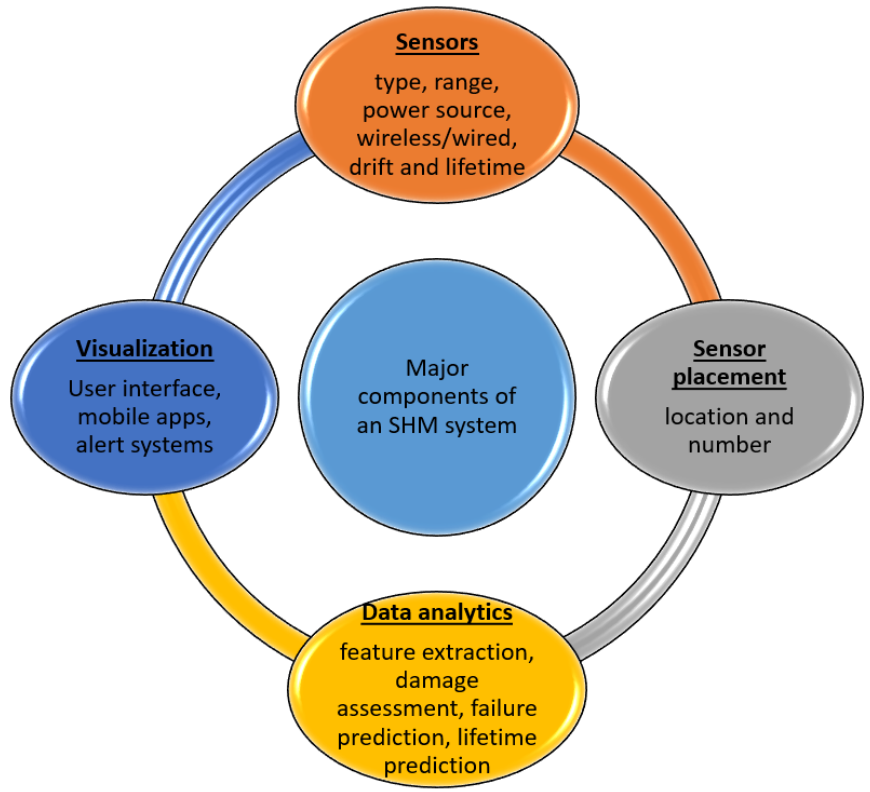
Figure 1. Main components of an SHM system.